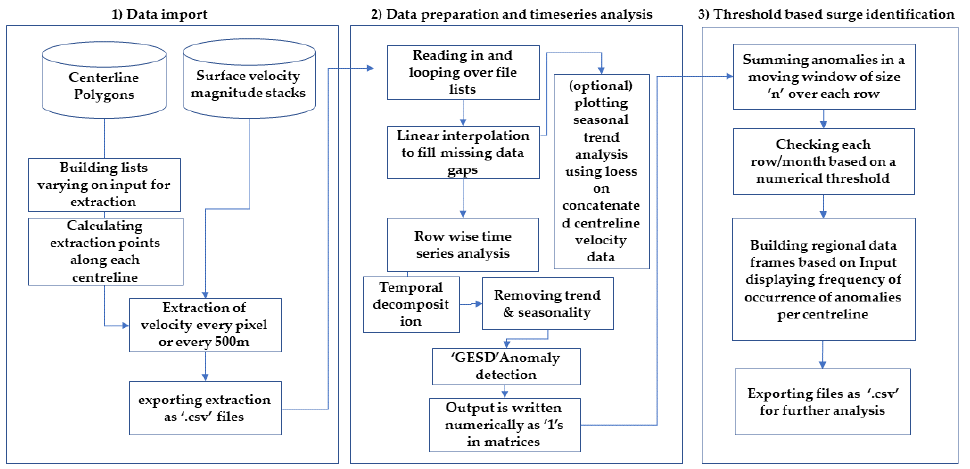
Figure 2. Flowchart of the algorithm divided in the three major processing steps: Data import, Data preparation and time series analysis and threshold-based surge identification.